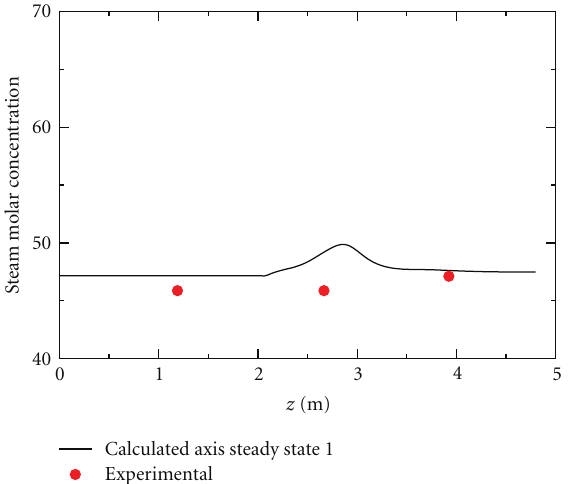
Figure 7: Vertical profile of the steam molar concentration along the axis: steady state 1.